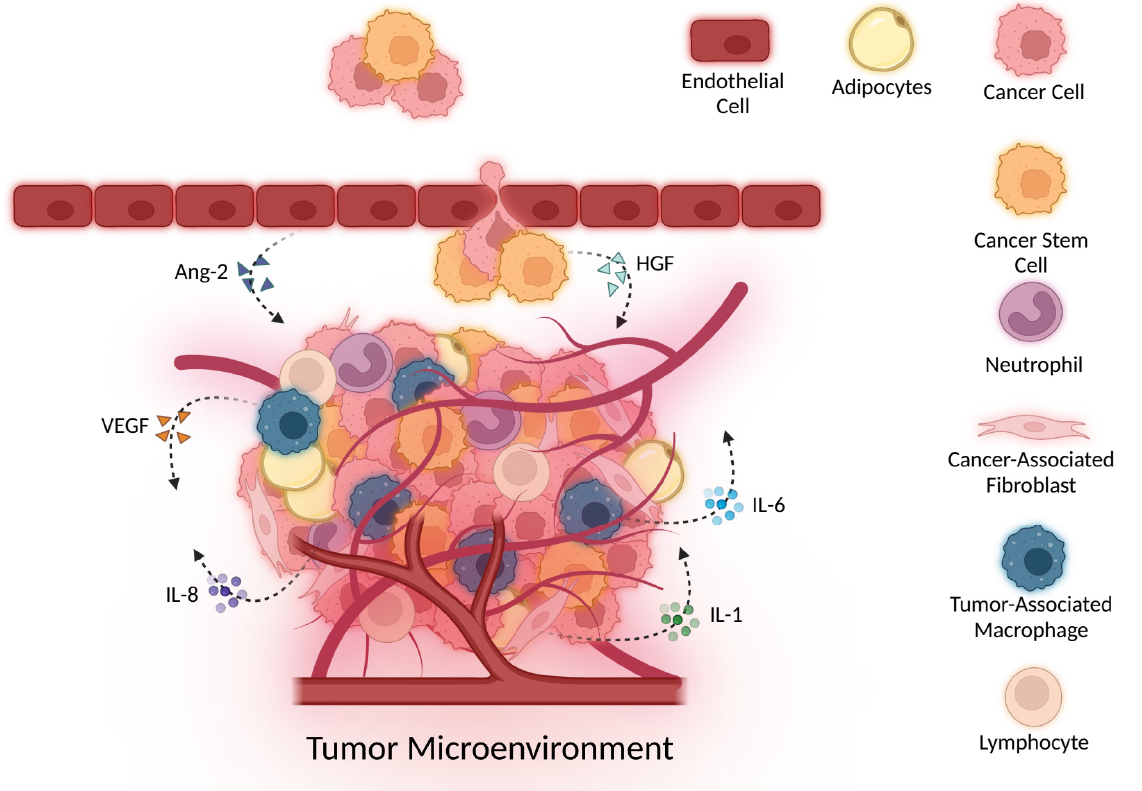
Figure 2. The TME is composed of a diverse group of cells, including cancer cells, CSCs, adipocytes, neutrophils, TAMs, CAFs, and lymphocytes. Various cytokines secreted by these cells enhance angiogenesis and overall tumor progression.